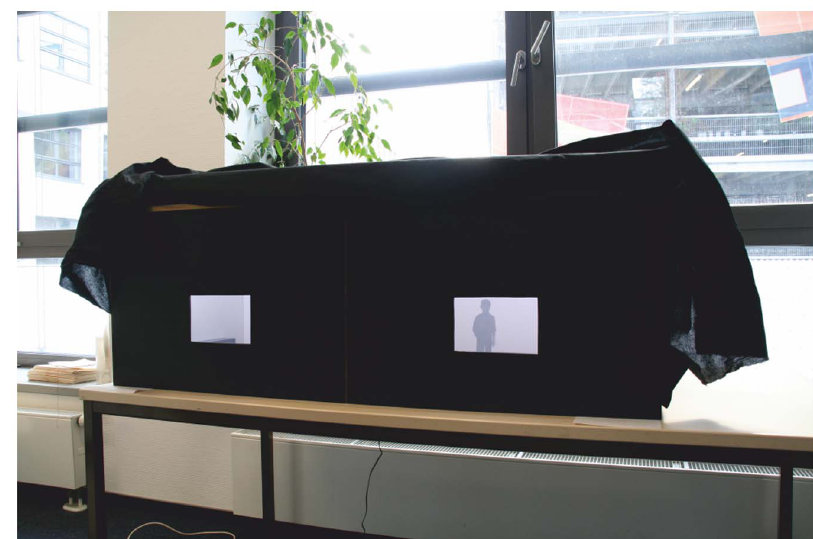
Figure 1. Experiment 1: Exterior view of the experimental setup.